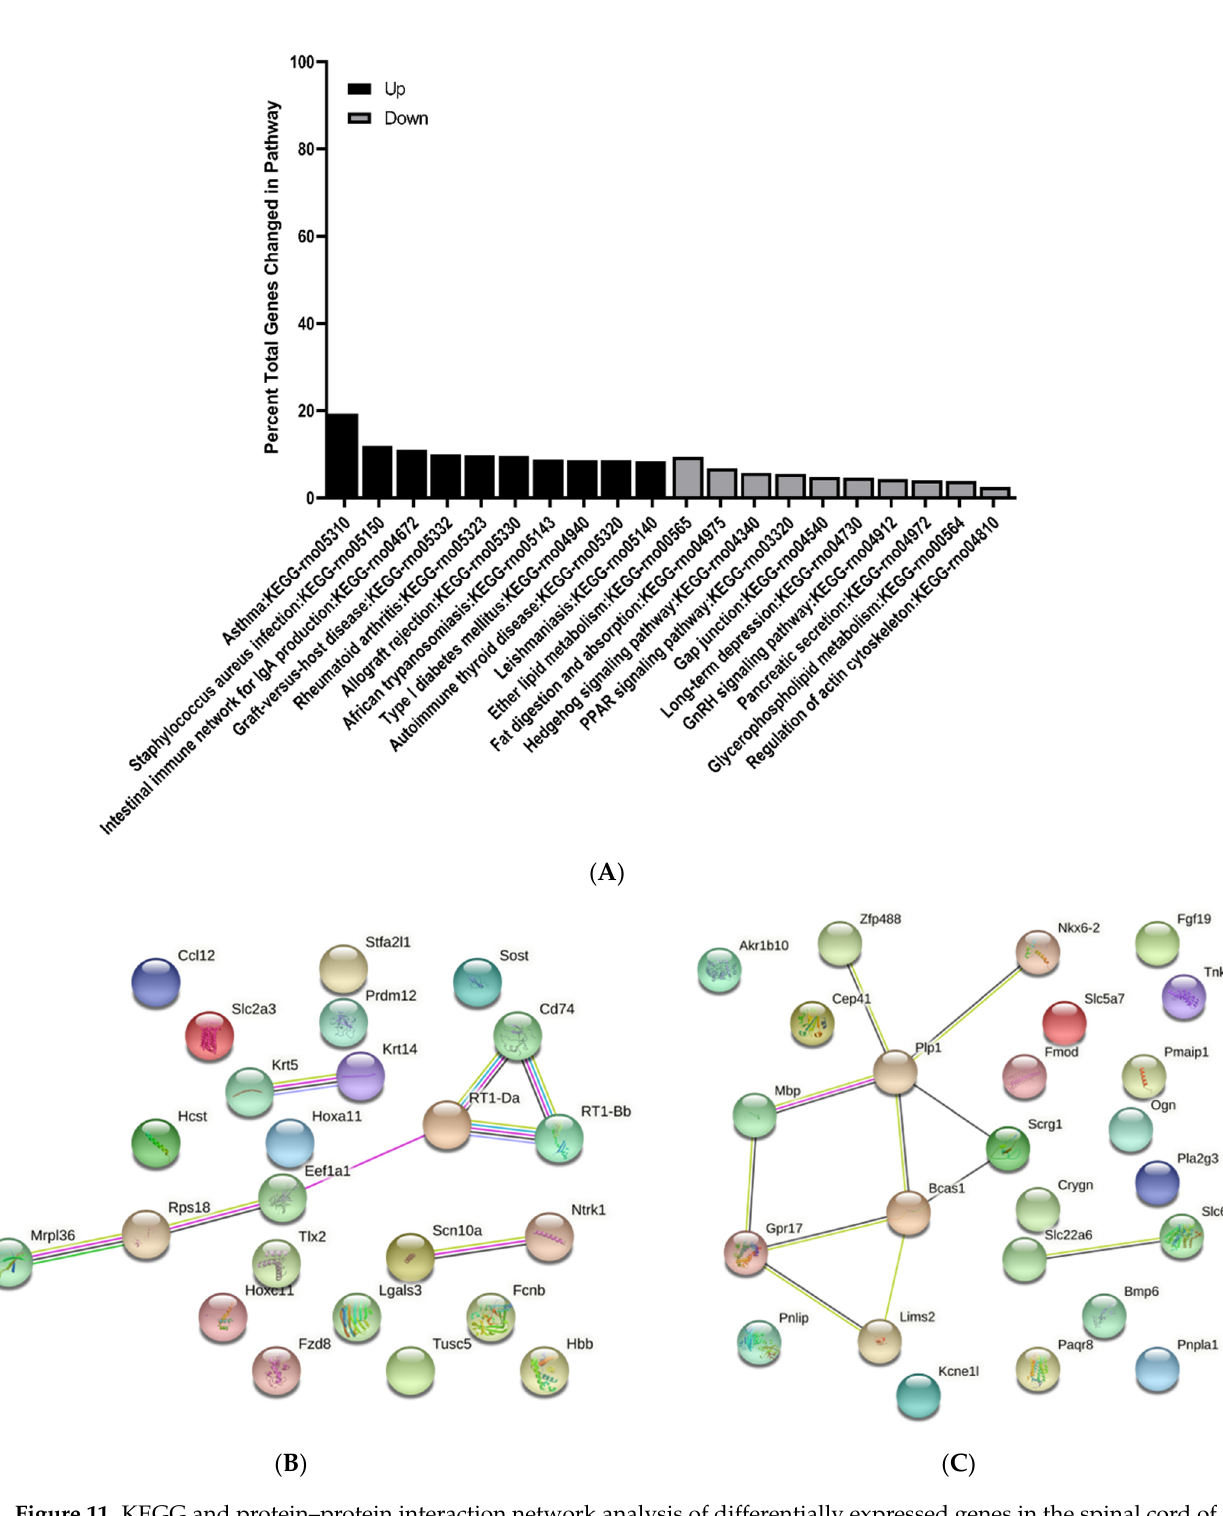
were determined for each time point by submitting the top 25 up and downregulated